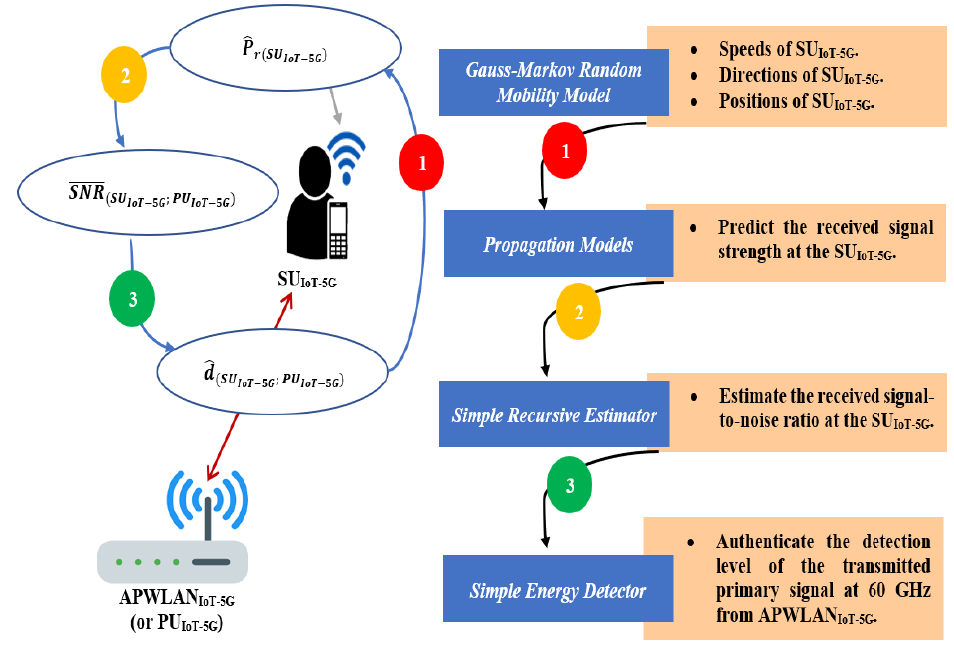
Figure 1. Proposed algorithm map: PS 5G sensing